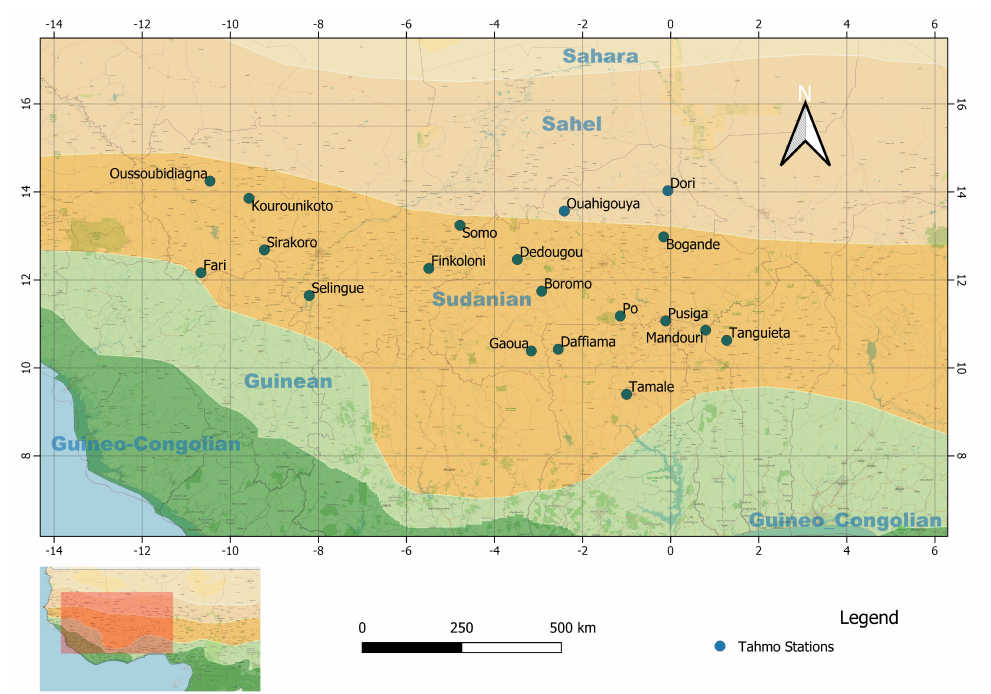
Figure 1. Agro-climatological regions in West Africa and the locations of the 20 TAHMO stations across the Sudanian region. Table 1. TAHMO stations, names and IDs, coordinates, mean annual rainfall ( ¯ Pan ) and